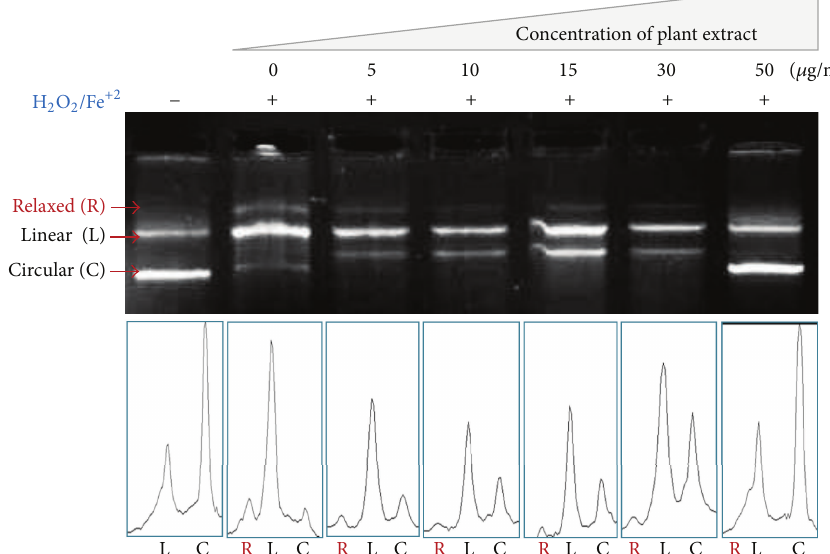
Figure 2: DNA protection assay of Desmostachya bipinnata hydroalcoholic extract. Treatment of pUC19 plasmid with hydroalcoholic extract in absence and presence of DNA nicking/damage causing Fenton’s reagent followed by the densitometric analysis of relaxed (R), linear (L), and circular (C) forms of pUC19 DNA (underneath agarose gel).